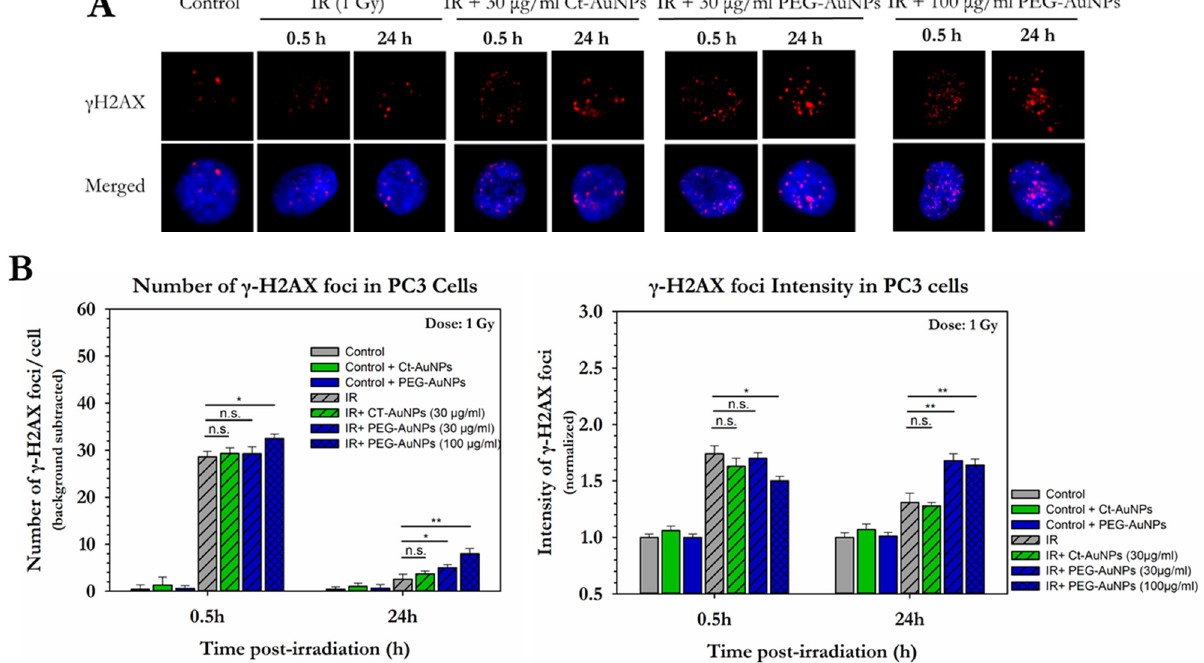
Figure 9. Quantitative and qualitative representation of DSBs in PC3 cells, after AuNP-induced radiosensitization with 1 Gy 320 KVp X-rays. ( A ) The nucleus is stained with DAPI, shown in blue, and the marker for DNA DSBs ( γ H2AX) is shown in red. ( B ) Figures show the average number of γ H2AX foci as well as the normalized foci intensity counted 0.5 h and 24 h after exposure. Statistical significance was determined using Student t test: * p ≤ 0.05, ** p ≤ 0.01, n.s.: not significant.